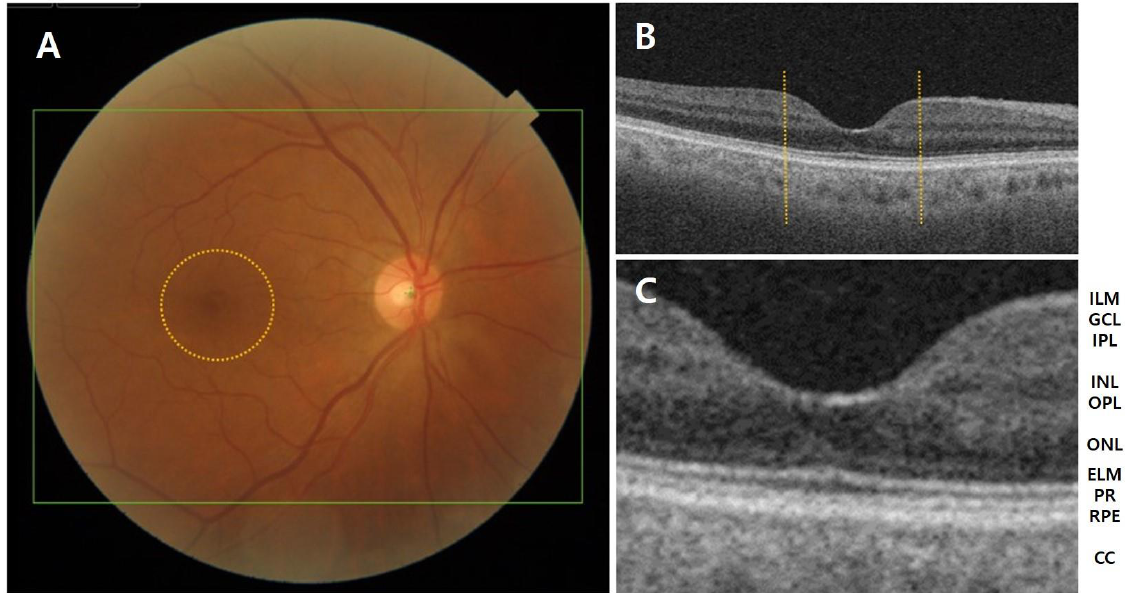
Figure 1. ( A ) Anatomy of the fundus and macula (circle) in a normal eye. ( B , C ) Layer-by-layer B-scan swept-source optical coherence tomography display of normal retina. CC, choriocapillaris; ELM, external limiting membrane; GCL, ganglion cell layer; ILM, inner limiting membrane; INL, inner nuclear layer; IPL, inner plexiform layer; NFL, nerve fiber layer; ONL, outer nuclear layer; OPL, outer plexiform layer; PR, photoreceptor; RPE, retinal pigment epithelium.